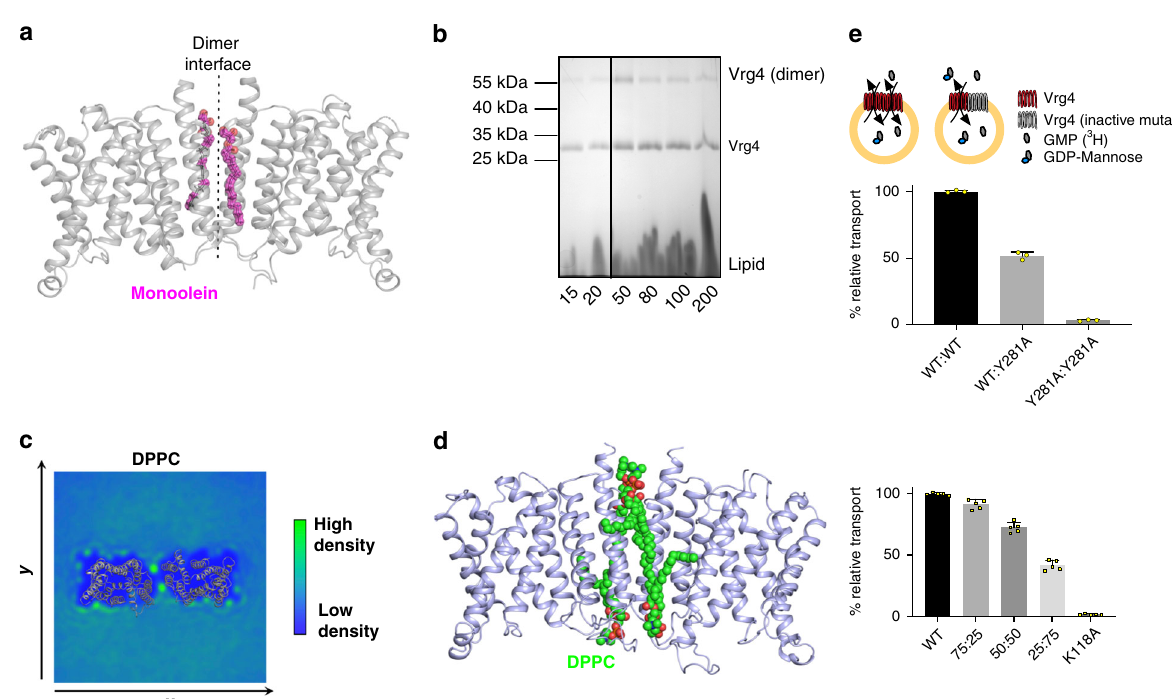
Fig. 4 Lipid mediated dimerisation of Vrg4. a Vrg4 dimer observed in the crystal structure with two monoolein lipid molecules (magenta), packed within the dimer interface (dashed line). b SDS – PAGE analysis of Vrg4 reconstituted at different ratios of protein to lipid, showing the presence of a dimer band at ∼ 55 kDa. c Density plot of DPPC lipids around the Vrg4 dimer, in a slice perpendicular to the membrane. Data were gathered using ca. 40 µ s of CG MD simulation, and calculated with the VMD volmap plugin. Speci fi c green regions highlight density present at the primary lipid binding region in the dimer interface. The Vrg4 dimer is shown in cartoon and overlaid for reference d Vrg4 dimer observed in the simulation shown in c with four DPPC lipids (green) within the dimer interface shown. e Dominant-negative assay showing the functional unit of Vrg4 is monomeric, and that Vrg4 forms dimers in a liposome. n = 3 (upper panel) or 5 (lower panel) independent experiments, errors shown are s.d. Source data are provided as a Source Data fi